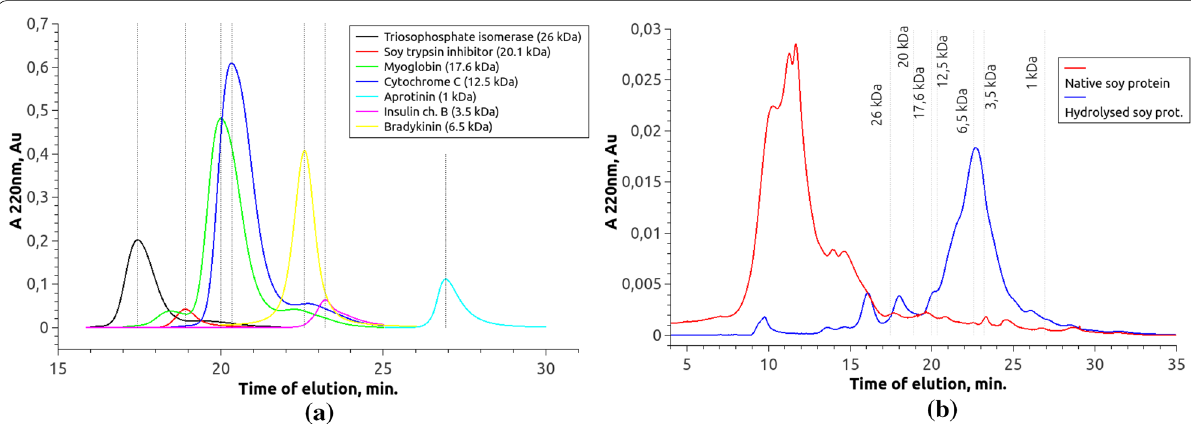
Fig. 6 Chromatogram of native SPI, SPI hydrolysate, as well as proteins and peptides with known molecular weights. a Chromatogram of proteins and peptides with known molecular weights; b comparison of the output time of native SPI components and SPI hydrolysate. The vertical lines correspond to the peaks of the markers on ( a ). The SPI hydrolysate was obtained by enzymatic hydrolysis of 20% SPI isolate Shansong 90 using commercial enzyme Protosubtilin G3x with protease activity 11.9 Units/g of SPI at 50 ◦ C with no